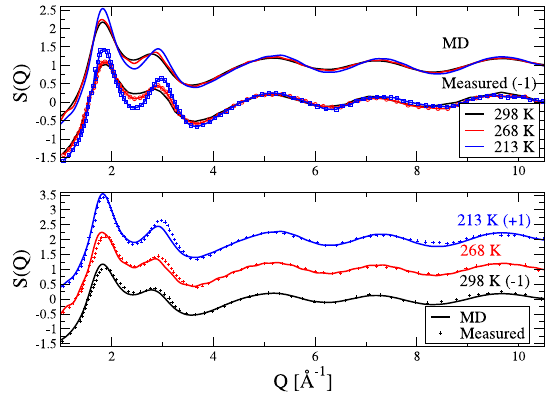
Figure 1. Temperature dependence of simulated and measured X-ray weighted total structure factors for the water-methanol mixture with a methanol molar ratio of 0.4. Upper panel: comparison of trends observed while lowering the temperature. Lower panel: individual comparisons of simulated and measured structure factors at three